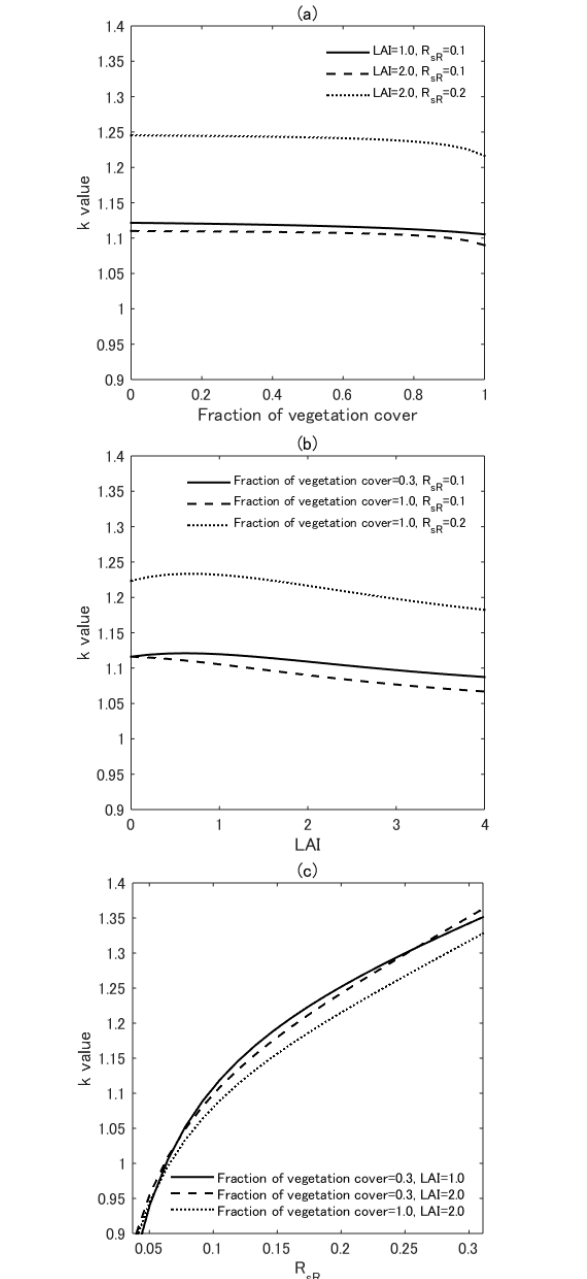
are plotted against FVC for “LAI = 1.0 and R sR = 0.1”, “LAI = 2.0 and R sR = 0.1”, and “LAI = 2.0 and R sR = 0.2”, denoted by the solid, dashed, and dotted lines, respectively. The k -values were relatively insensitive to the changes in FVC. The differences between the k values for FVC = 0.0 and FVC = 0.9 were less than 1%, and the differences for FVC = 0.0 and FVC = 1.0 were less than 3% for each pair of LAI and R sR . The strong dependence of R sR on k was identified from the large differences between the k -value curves obtained at R sR = 0.1 and = 0.2.